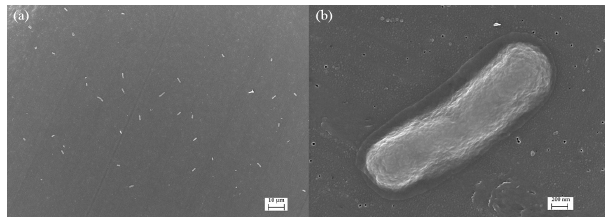
Figure 8. Detail of Escherichia coli in physiological solution, mag- nifications 2000 × in panel (a) and 100000 × in panel (b)